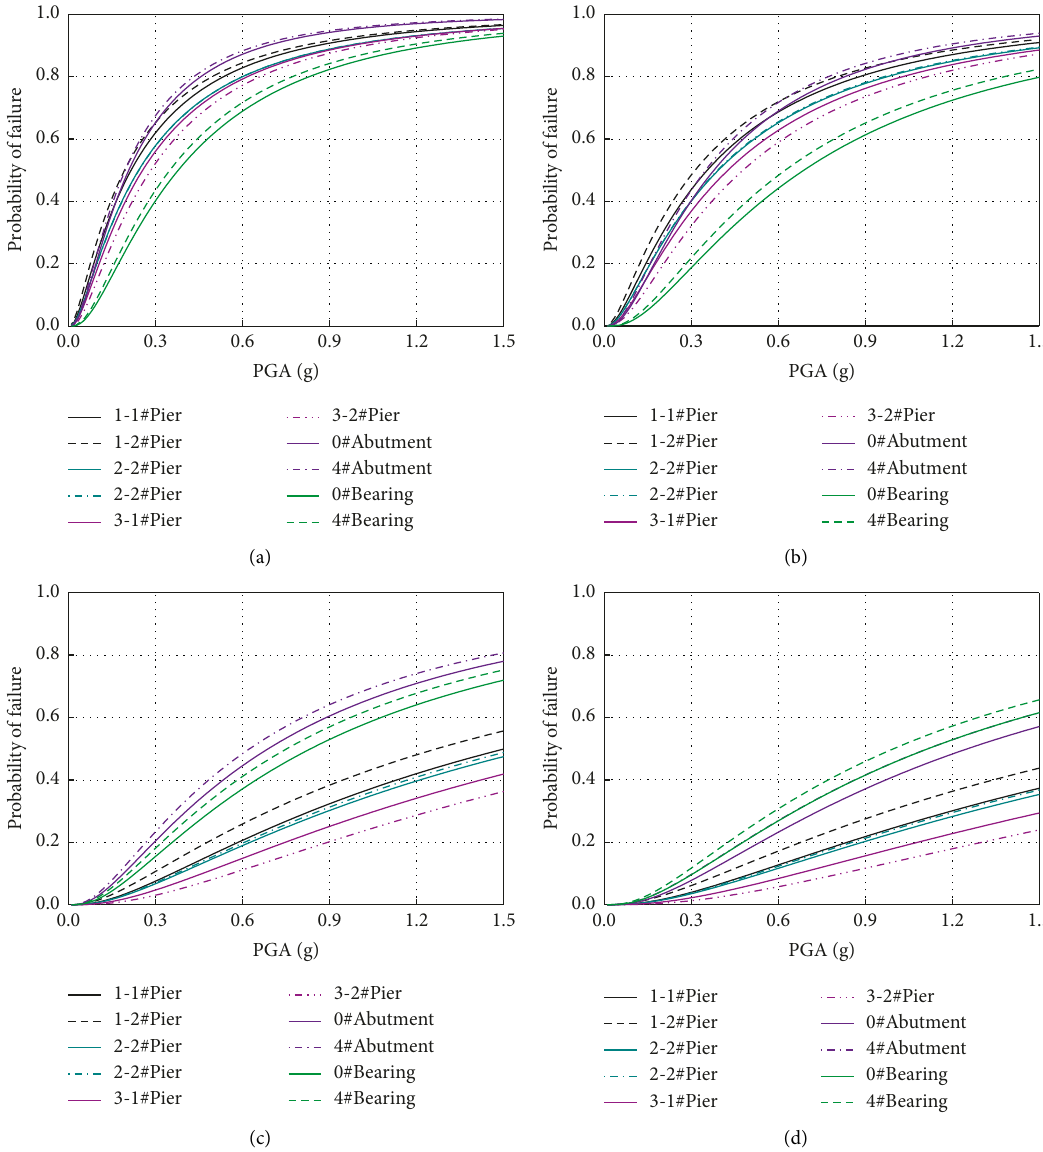
Figure 8: Seismic vulnerability curves of components: (a) slight damage; (b) moderate damage; (c) serious damage; and (d) complete